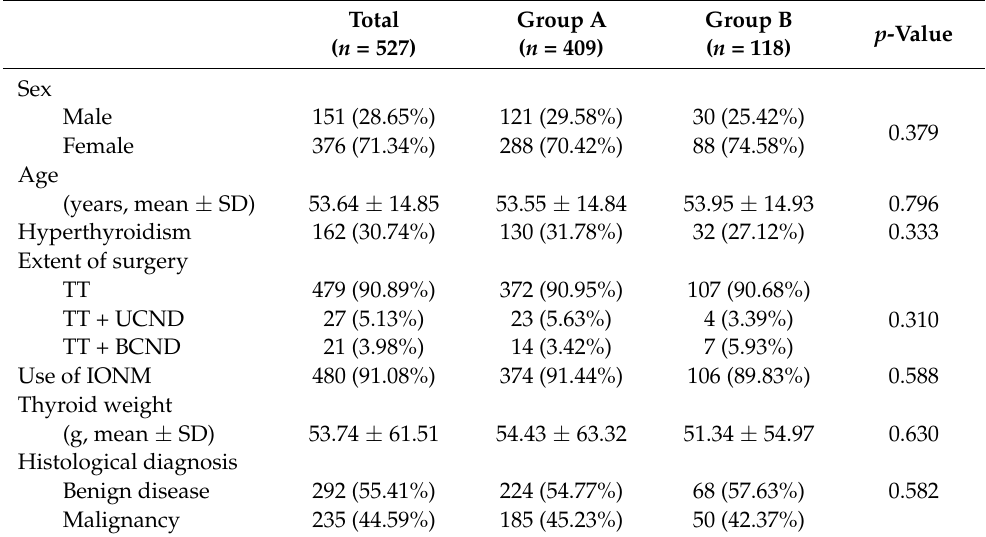
Table 1. Demographic data, information on thyroid function, information about the surgical proce- dure, and histological